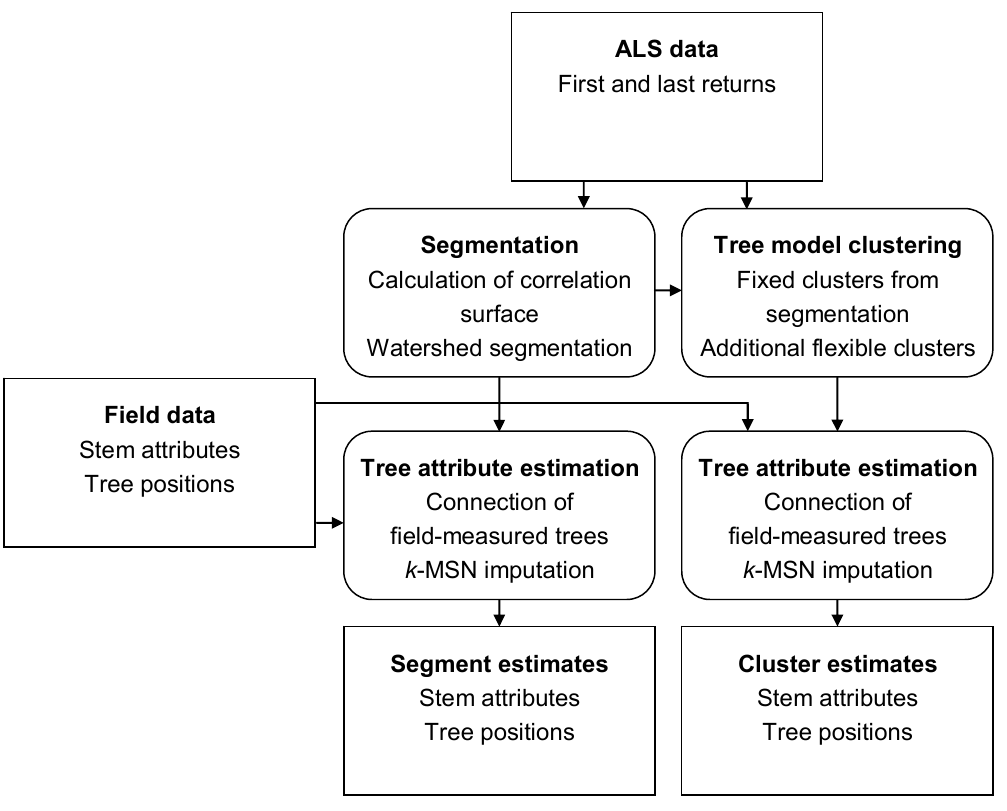
Figure 4. Flow chart of the methods. The squared boxes contain data and the rounded boxes show the different parts of the